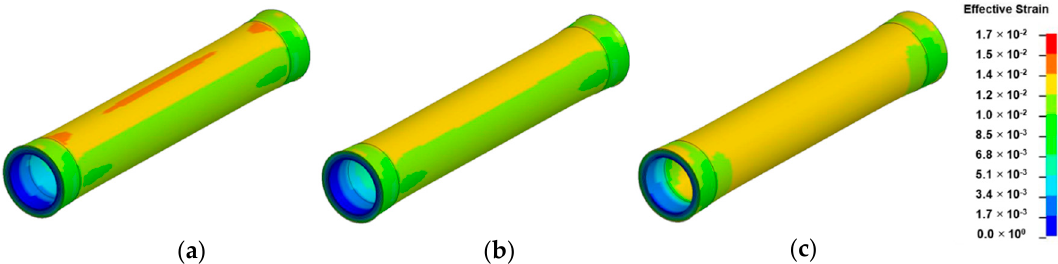
Figure 12. Fringe plots of effective strain of: ( a ) exponential; ( b ) linear and ( c ) constant shrinkage models in intermodal unit of bamboo culm due to effect of thermal contraction.